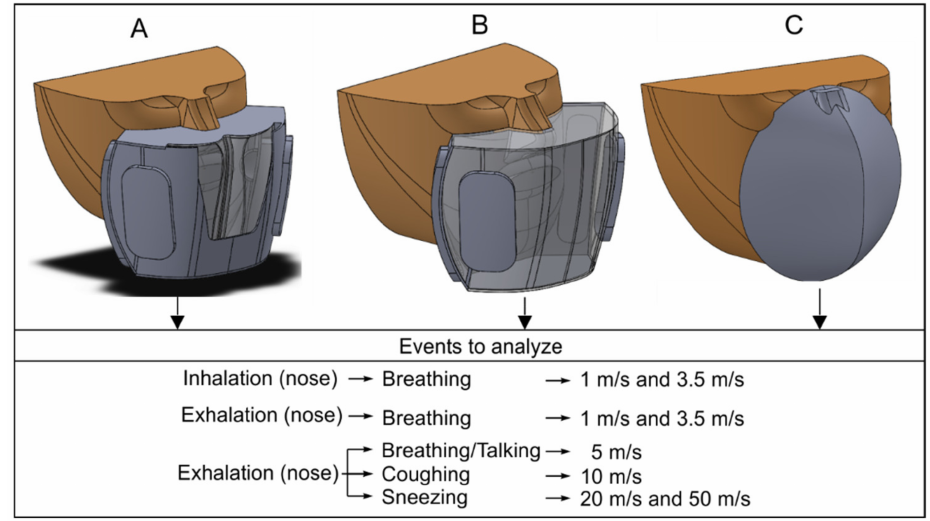
Figure 4. Comparison of the mask geometries analyzed with CFD; ( A ) mask with interior static spiral valves; ( B ) mask without interior valves, and ( C ) KN95 commercial